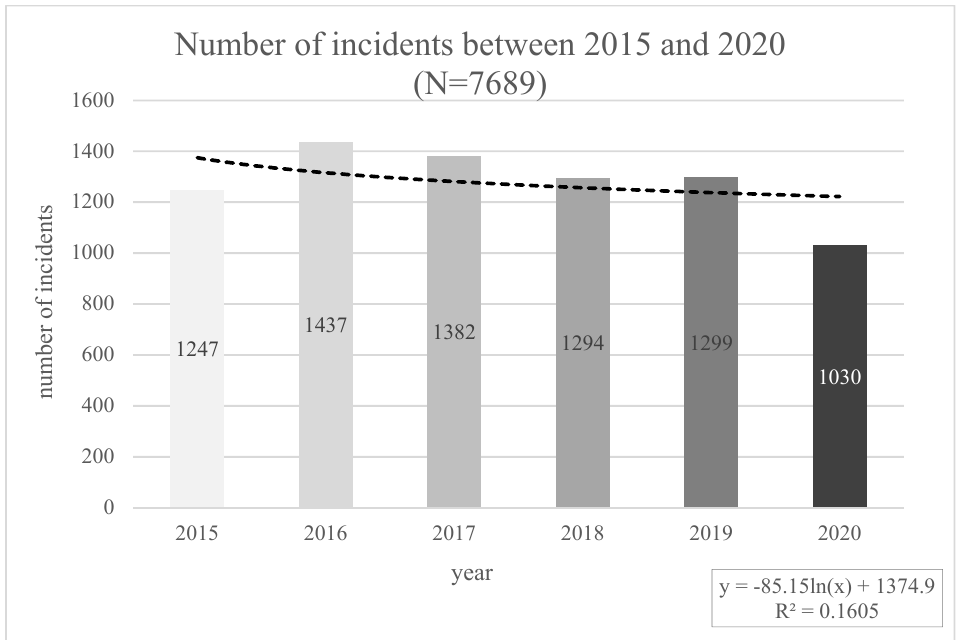
Figure 1. The number of incidents between 2015 and 2020. i.e., Grunwald ( n = 943; 12.3%), New Town ( n = 831; 10.8%) and Old Town ( n = 792; 10.3%). The smallest number of orders came from the Konin City Police Station and the Czer- niejewo Police Station (Table 1). Table 1. The number of incidents by the commissioning entity .